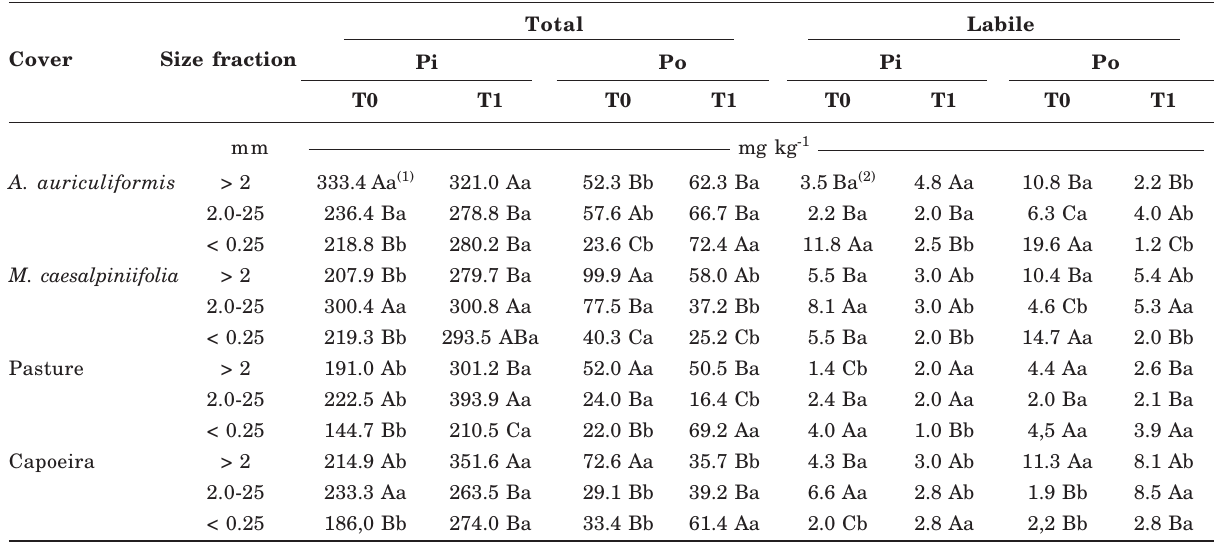
Table 5. Contents of total organic (Po), labile inorganic (labile Pi) and organic (labile Po) phosphorus in different size fractions and vegetation covers at incubation time zero (T0) and after 90 d of incubation